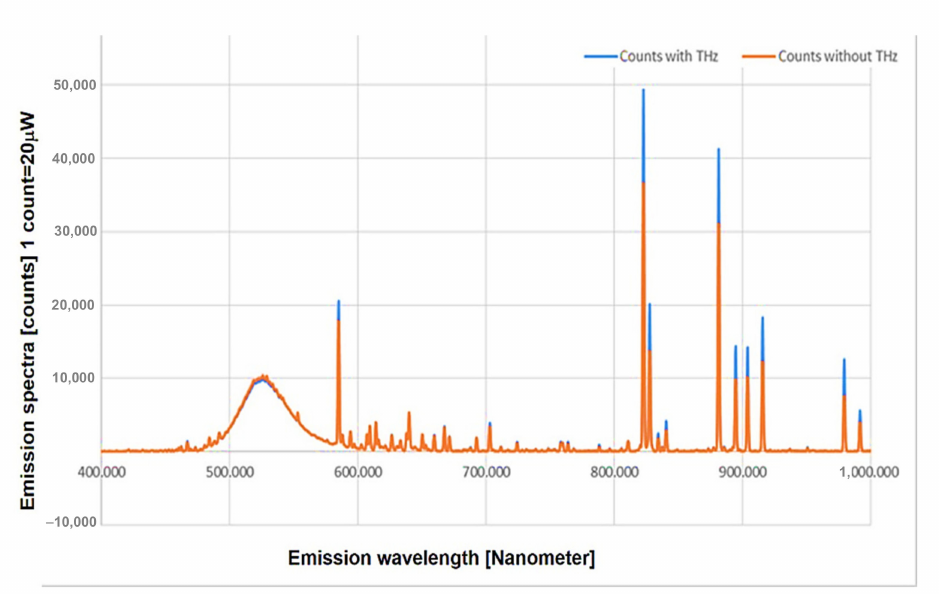
Figure 3. Emission spectra of GDD N527 with MMW/THz influence (blue line) and without MMW/THz influence (orange line). One count is equal to 20 µ W. (Courtesy of Prof. Dr.